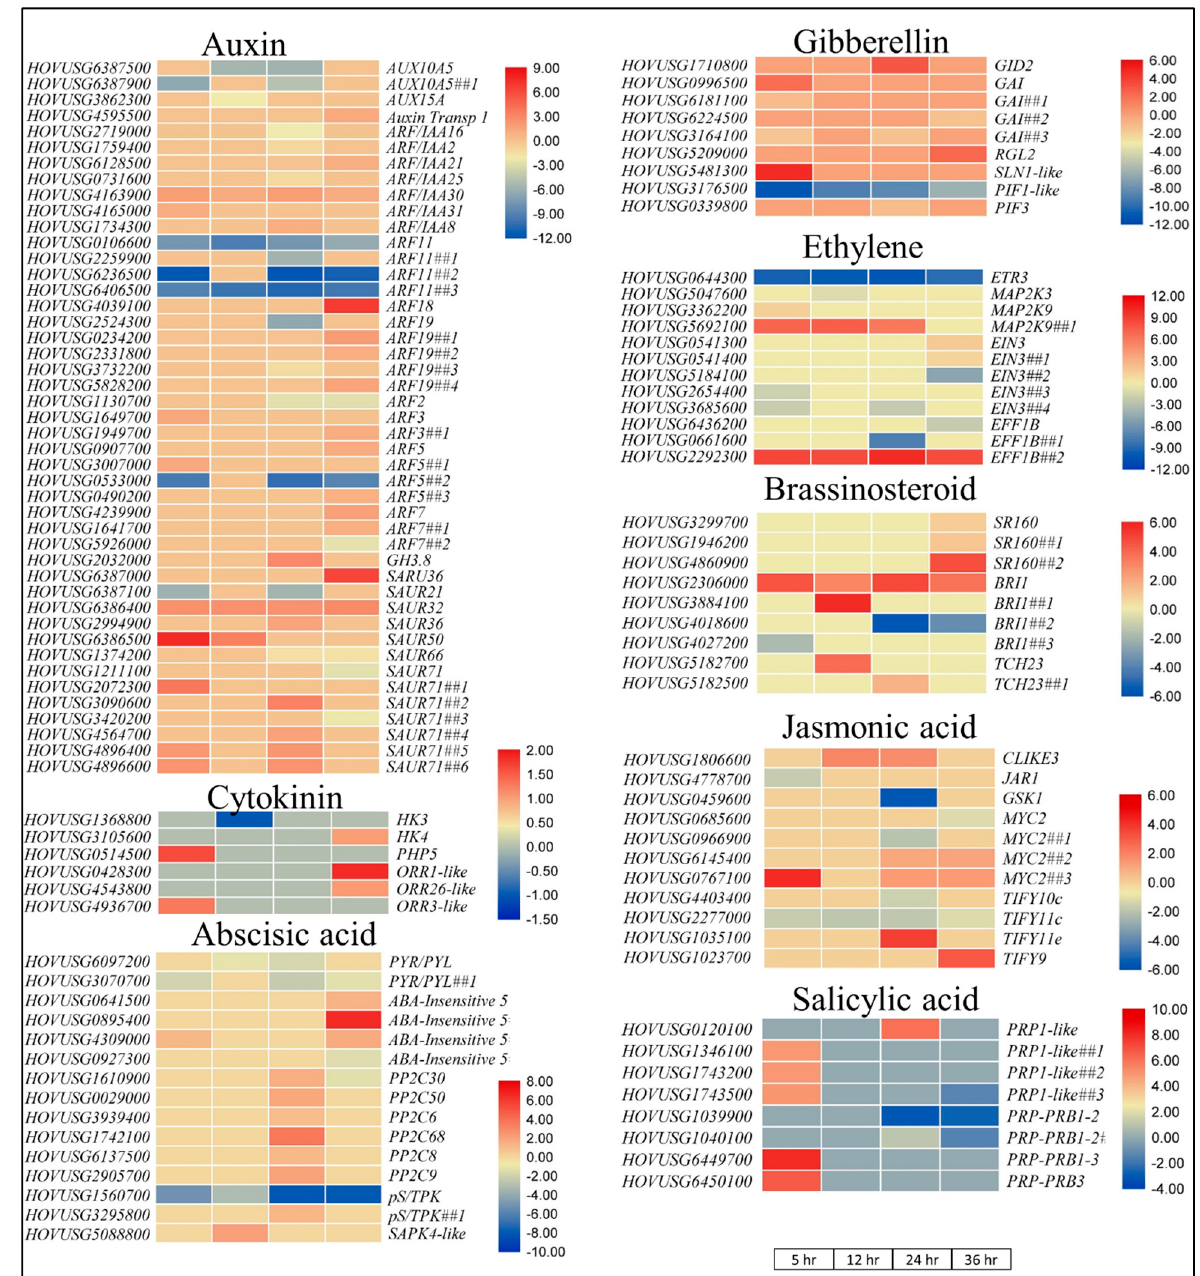
Figure 4. Heatmaps of log2 FC values of DEGs (in XL19/ZYM1288) that were significantly enriched in plant hormone signaling pathway.